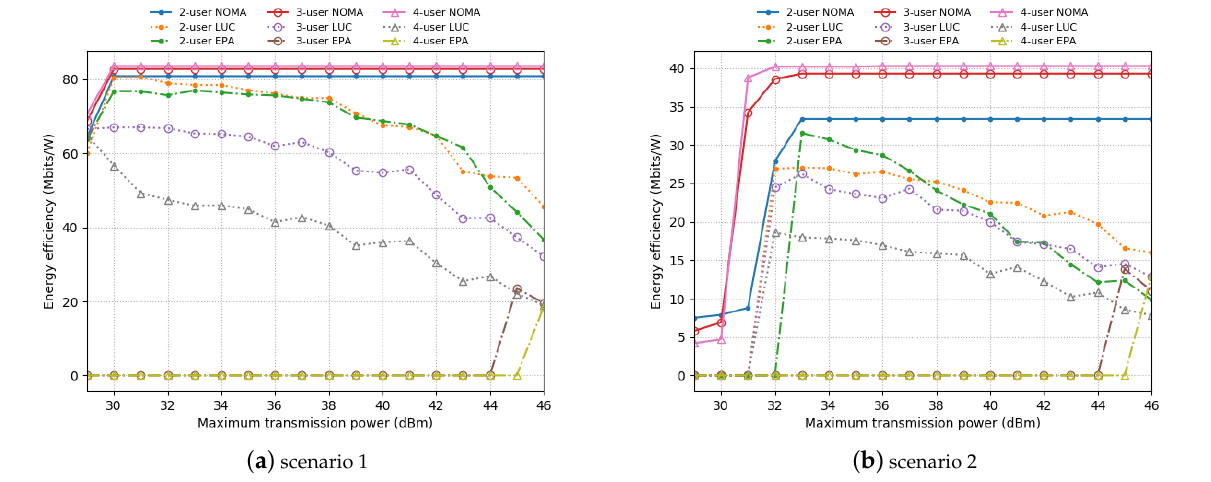
Figure 6. Energy efficiency versus maximum transmission power of BS for NOMA systems equipped with the proposed user clustering and power allocation methods, location-based user clustering strategy, and equal power allocation scheme.